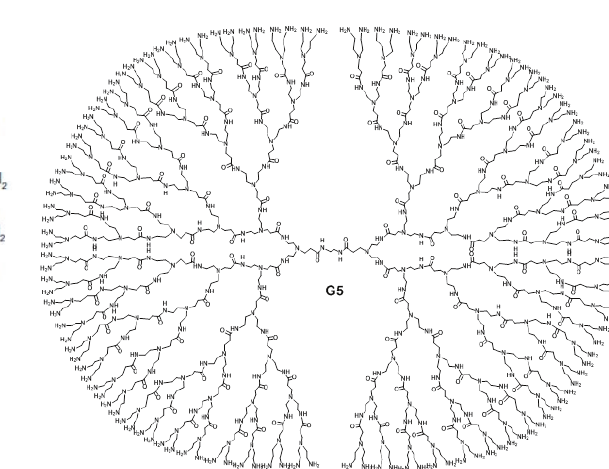
Figure 4: Poly(EThyleneAmidoAmine